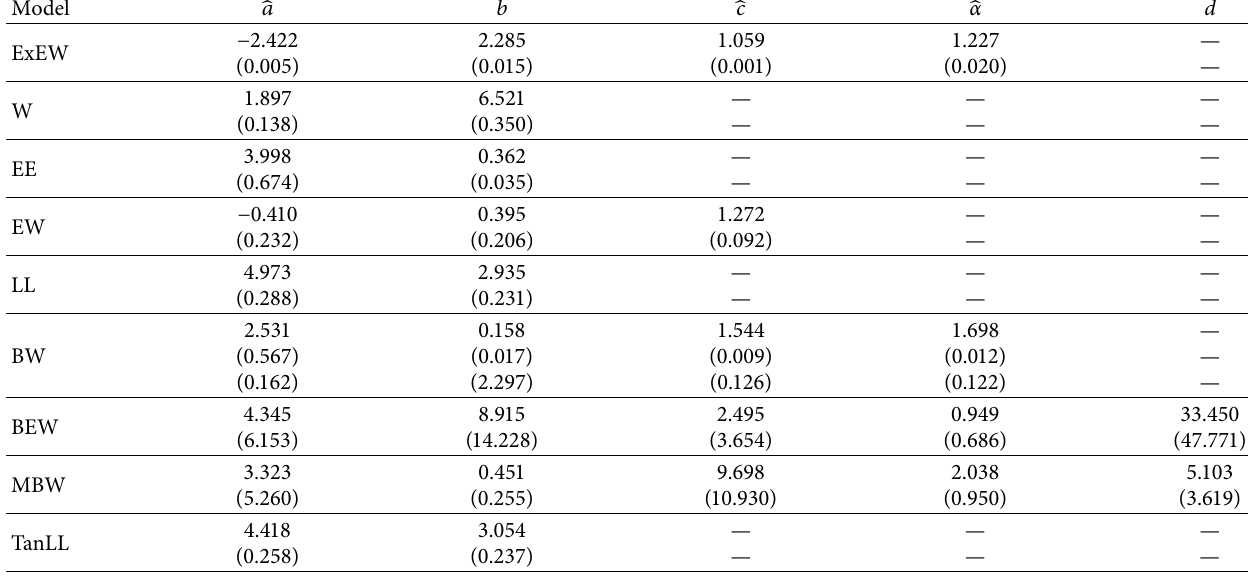
Table 12: MLEs of the competing models with standard errors for COVID-19 fatality rate data.